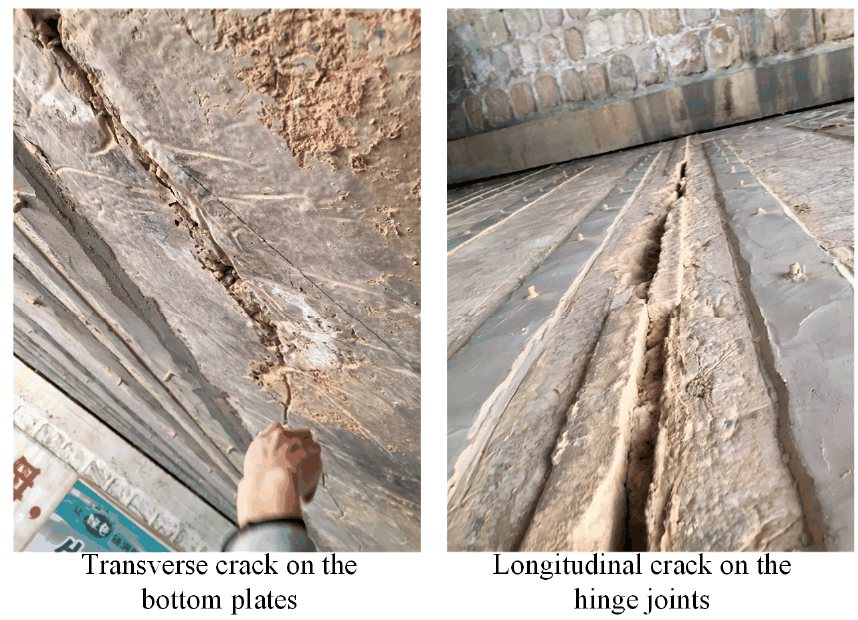
Figure 7. Main defects in the visual inspection. In order to quantitatively evaluate the surface damage, the characteristics of the main defects were obtained including the location and length and width of the cracks. Table 6 shows the location of the cracks in the longitudinal direction. It could be found that the transverse cracking on the bottom plates of the girders mainly occurred in the mid-span of the bridges, while the distribution of the longitudinal cracks on the joints was quite uniform along the longitudinal location except the through cracks. The through cracks along the span length account for 37.1% of all the cracks, indicating the severe damage of the joints after 25 years’ service life. Table 6. Location distribution of the main defects. Transverse Cracks on the Longitudinal Cracks on the Bottom Plates Hinge Joints